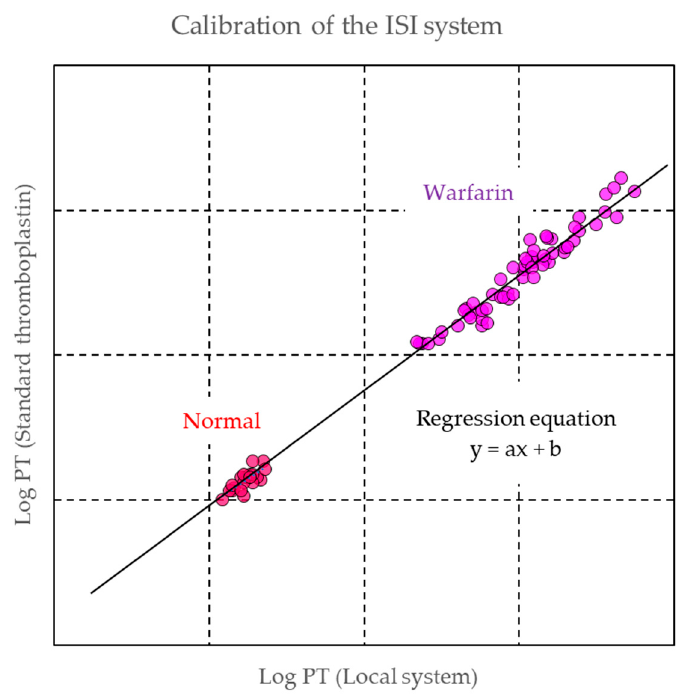
Figure 3. Example of a calibration line for determination of international sensitivity index (ISI). The prothrombin time (PT) clotting times of all samples including 20 normal (red) and 60 warfarin (purple) samples are measured by the employed instrument/reagent with the reference thromboplastin and the manual technique (WHO method), and the logarithms of the PT values employed are plotted against the logarithms of the PT values assigned by using WHO method. The regression equation is calculated, and the slope of the line is established. The ISI value of the employed instrument/reagent is calculated as: ISI = slope × ISI (ref) where ISI (ref) is the ISI of the reference thromboplastin.